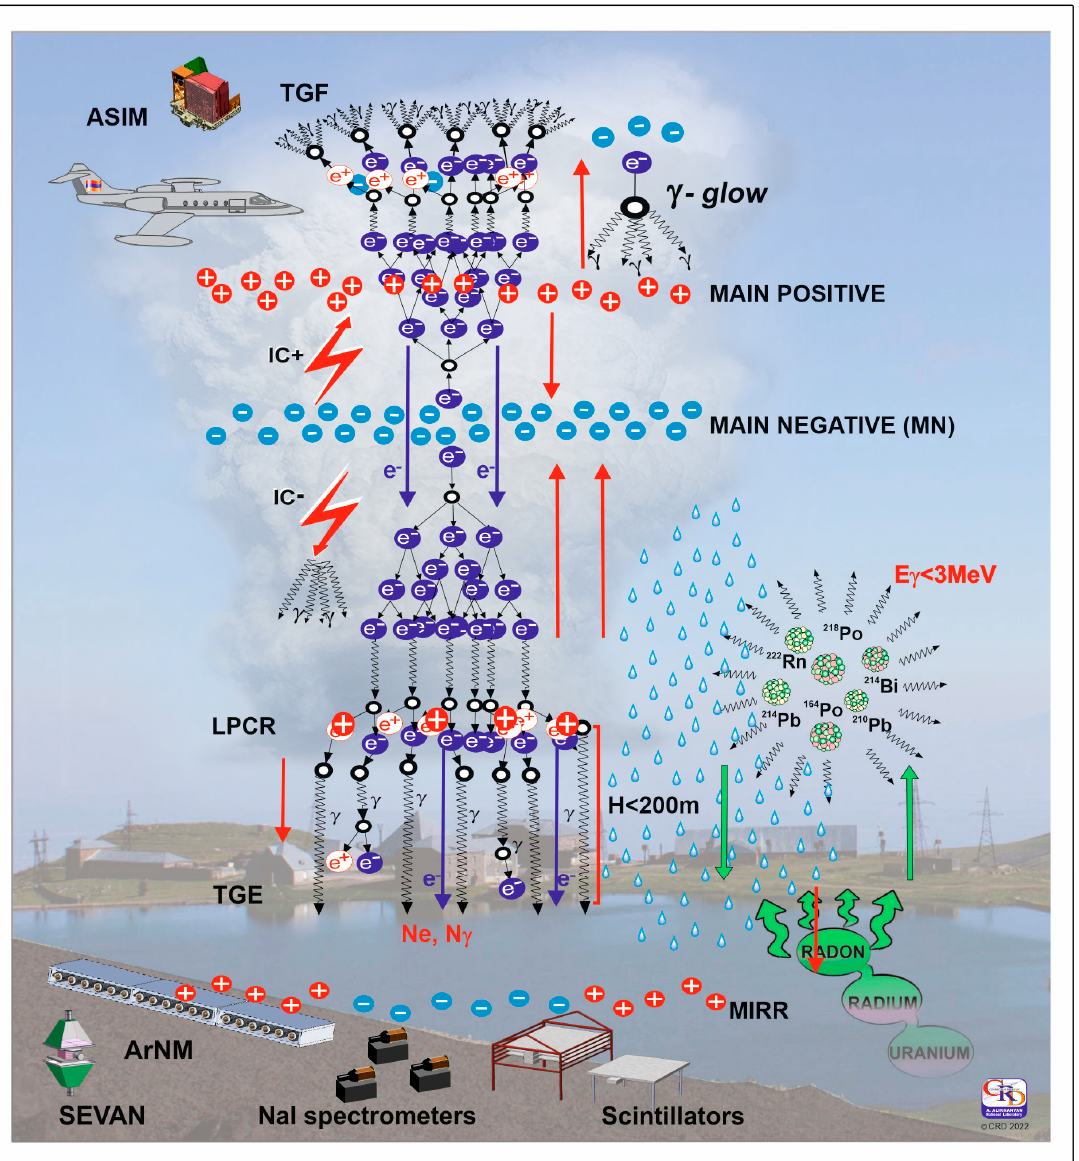
Figure 1. Charged structures and particle fluxes associated with a thunderstorm. On the left are particle avalanches developing in a thundercloud, and on the right are emissions of 222 Rn descend- ants. The red arrows show atmospheric electric fields and lightning flashes. ©PRD. Reproduced with permission.